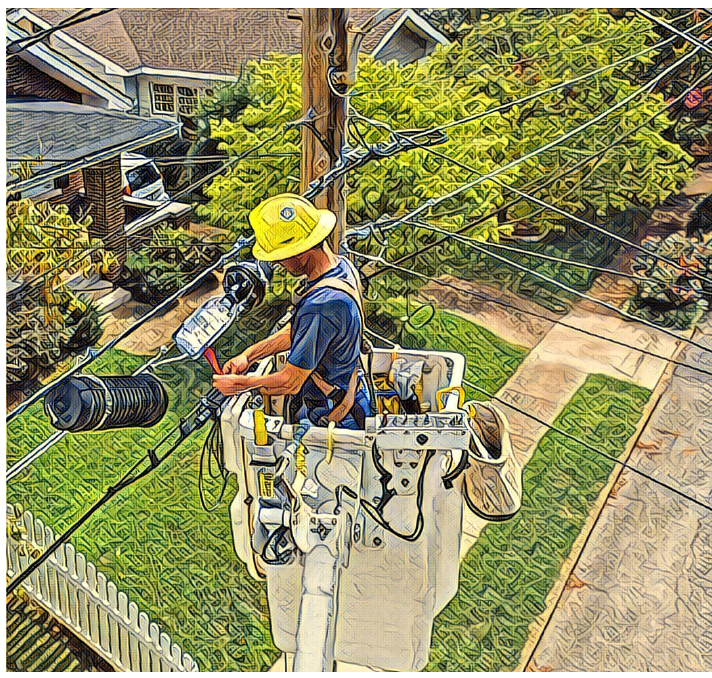
Figure 7. An illustration of SAIT for maintenance scenario.